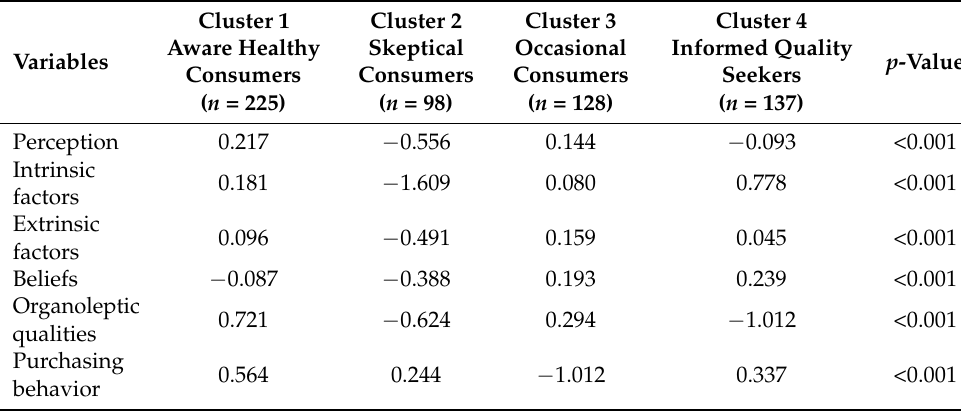
Table 4. Results of cluster analysis using k-means